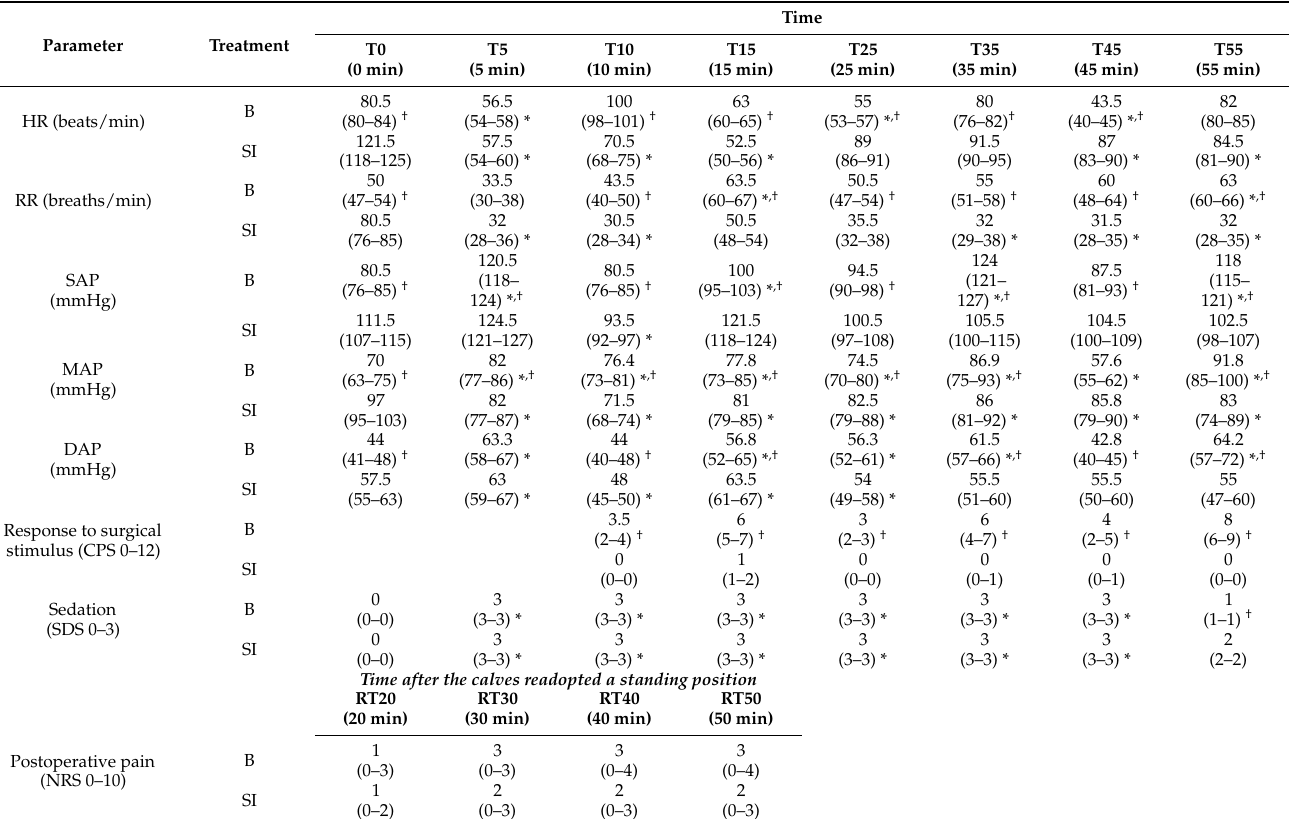
Table 1. Effect of romifidine (0.08 mg/kg IM) followed by tramadol (1 mg/kg IV) administered either as a bolus injection (B group, n = 10) or a slow injection over 10 min (SI group, n = 10) on heart rate (HR), respiratory rate (RR), systolic, diastolic, mean arterial pressure (SAP, DAP, MAP), response to surgical stimulus (cumulative pain scale; CPS), quality of sedation (simple descriptive scale; SDS), and postoperative pain (numerical rating scale; NRS) in calves undergoing umbilical hernia repair. Romifidine was administered immediately after obtaining baseline values (T0) and tramadol just after recording the T5 assessment (5 min after romifidine administration). Postoperative pain was assessed at the reported times after the calves recovered a standing position.